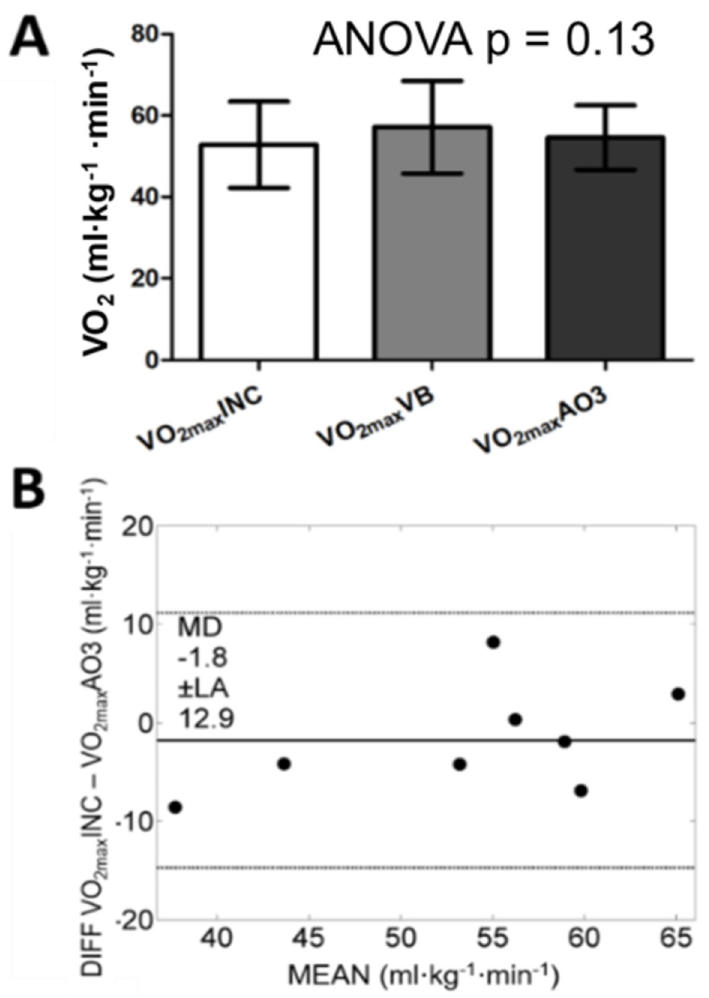
Fig 6. Comparison of _ V _ O obtained in the graded exercise test (INC), the verification bout (VB) and the AO3 (A), 2 max and Bland Altman between INC and AO3 (B).